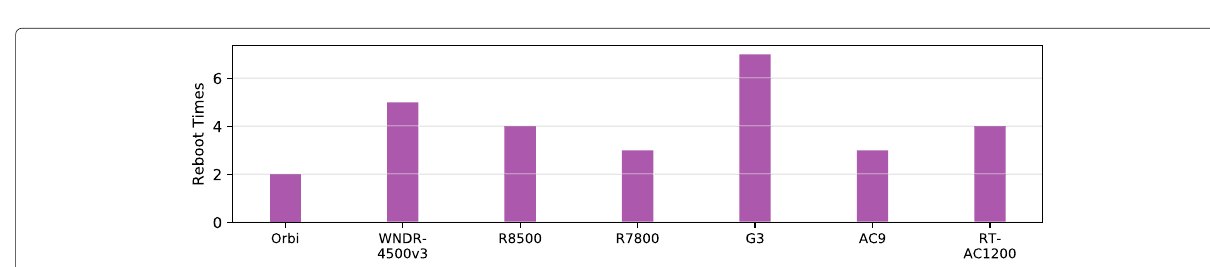
Fig. 11 Device Reboot Times of D-CONF mode